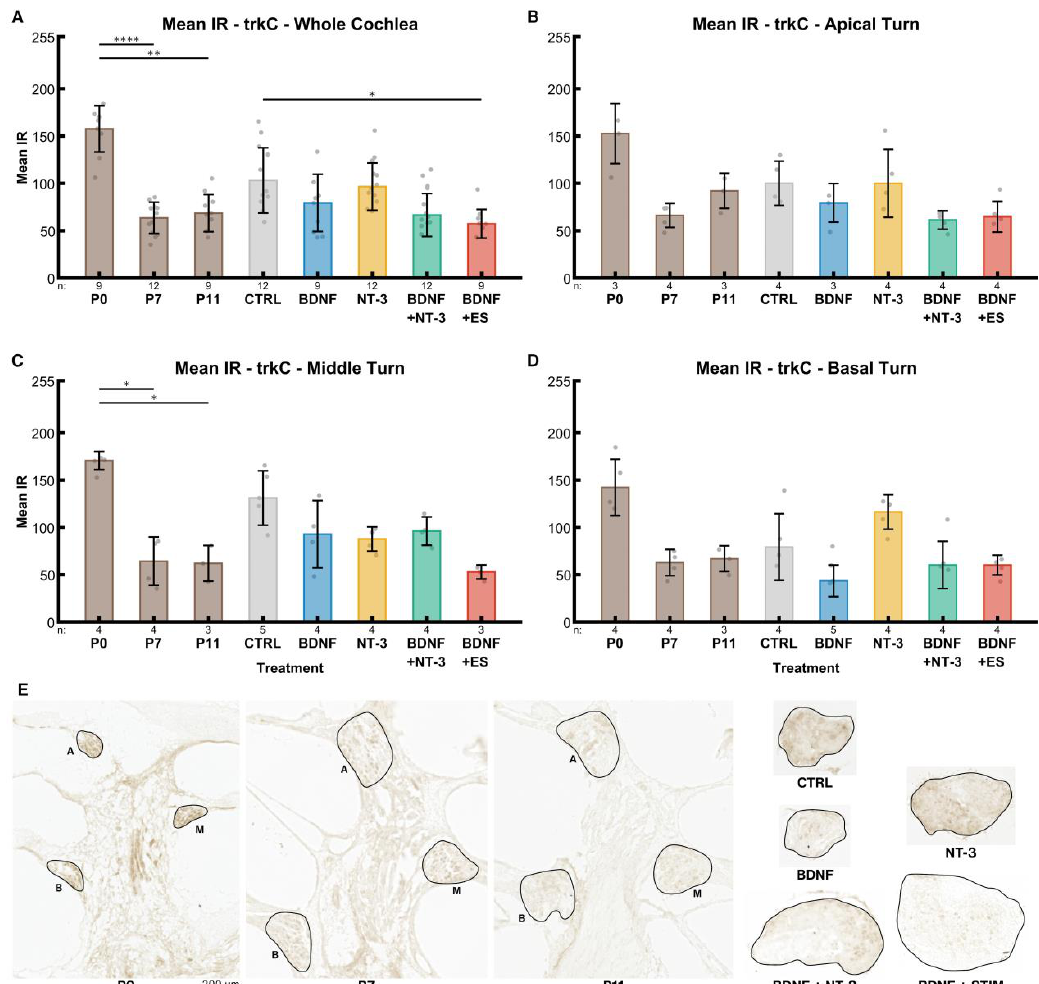
Figure 7. TrkC receptor expression. The diagrams ( A – D ) show the mean IRs of DAB-positive areas of histological sections in different age groups (P0–P11) and explant sections after different treatments (untreated (NT CTRL), 25 ng/mL BDNF, 200 ng/mL NT-3, 25 ng/mL BDNF + 200 ng/mL NT-3 and 25 ng/mL BDNF + 500 µA). The groups in the first graph ( A ) contain an equal number of samples from three turns, hence representing the whole cochlea. Diagrams ( B – D ) depict the individual turns. ( A – D ) The whiskers denote the standard deviation. Individual samples are marked as grey dots. The number of samples in each group is written right below the X-axis. The asterisks or ns (not significant) above the groups indicate the significance level of a Kruskal–Wallis test followed by a Dunn’s multi- comparison post-hoc test. The DAB intensities of P0–P11 pups were tested among themselves, and the treated explants were compared with the control and the P11 group. Non-significant differences between groups are not highlighted. ( E ) Representative sections closest to the median mean IR of the groups in ( A ). The solid black lines mark the regions of interest. A, M and B denote apical, middle, and basal turns, respectively. The explant sections are all from the middle